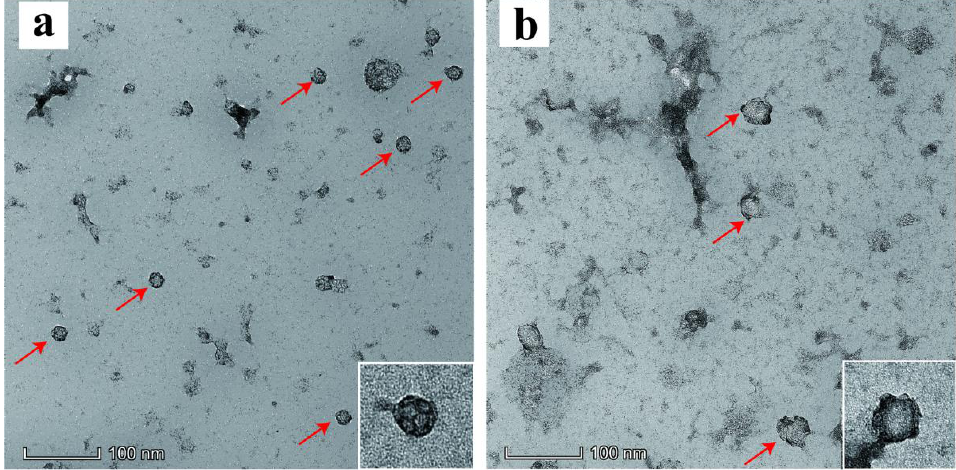
Figure 3. Observation of morphology under a transmission electron microscope (red arrow). ( a )